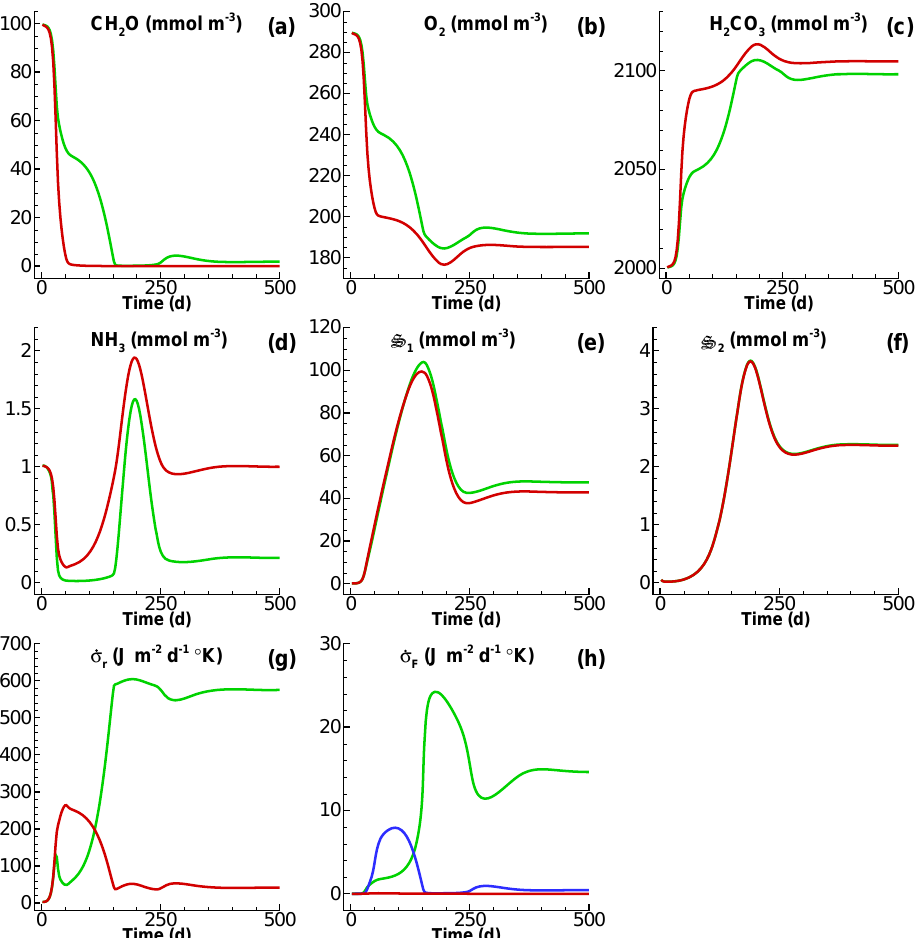
Fig. 3. Concentration of state variables (a–f) and entropy production from reactions (g) and mixing (h) for the point ( ε 1 [1], ε 2 [1], ε 1 [2], ε 2 [2]) = (0.1, 0.05, 0.1, 0.05) based on Eq. (17). In (a–g) , green line represents variables in box [1], while red line is for variables in box [2]. The green, blue and red lines in (h) correspond to entropy of mixing between boundary [0] and box [1], box [1] and box [2], and box [2] and boundary [3],